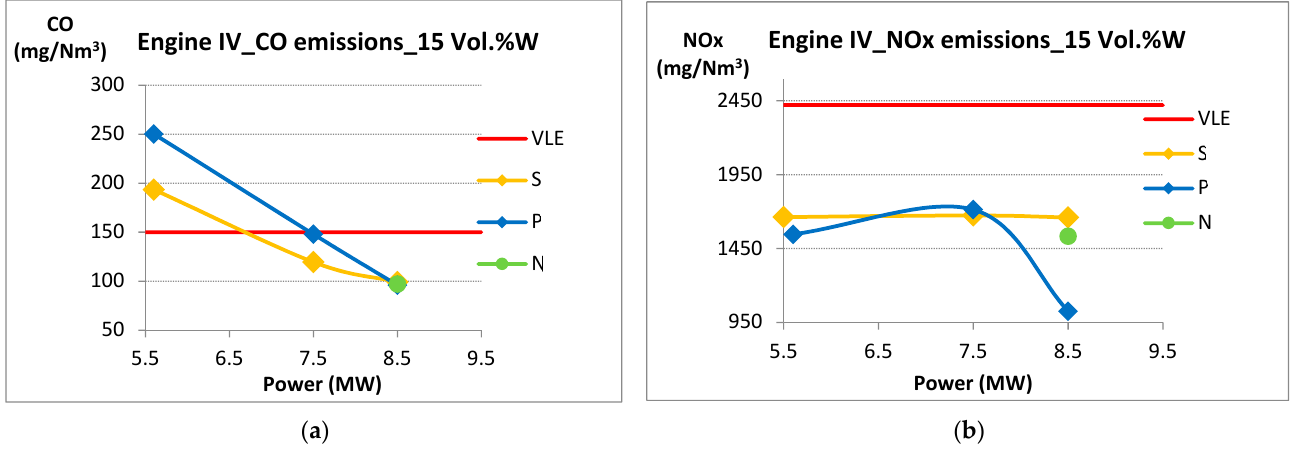
Figure 29. Engine IV: emissions measured with a water addition percentage of 15% v / v . ( a ) CO emissions on engine IV; ( b ) NOx emissions on engine IV. Results obtained have shown a reduction of CO and NOX emissions when the power